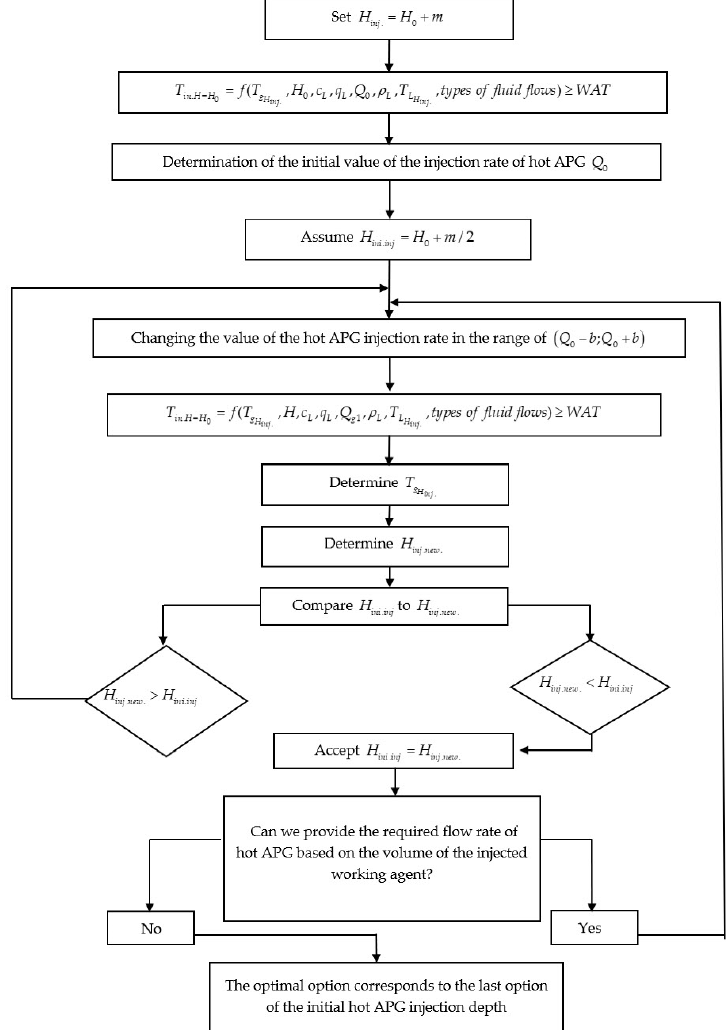
Figure 5. Algorithm for determining the optimal injection depth and flow rate of hot associated petroleum gas in a gas-lift well.